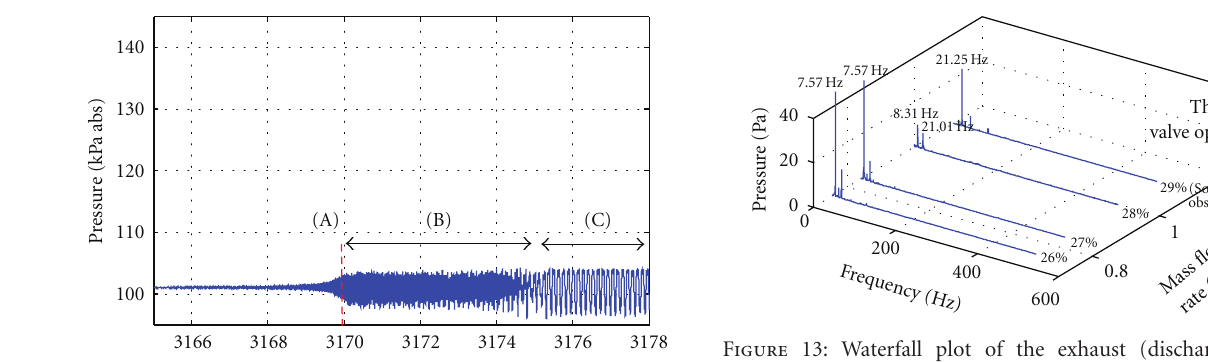
Figure 13: Waterfall plot of the exhaust (discharge plenum) pressure at 15,000 rpm.